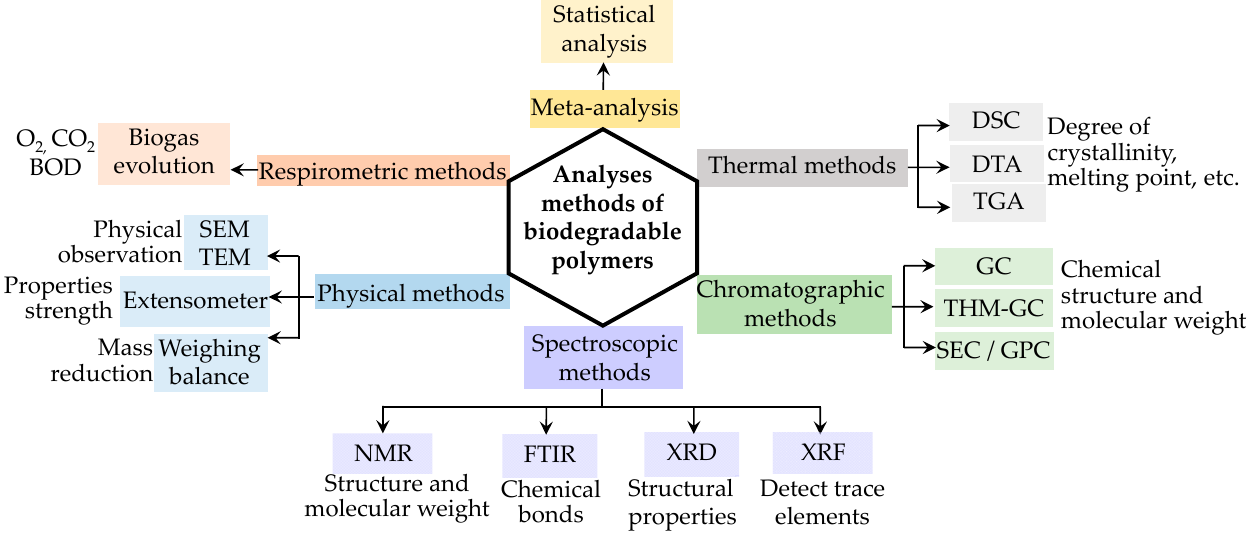
Figure 1. Analytical methods of biodegradable polymers.